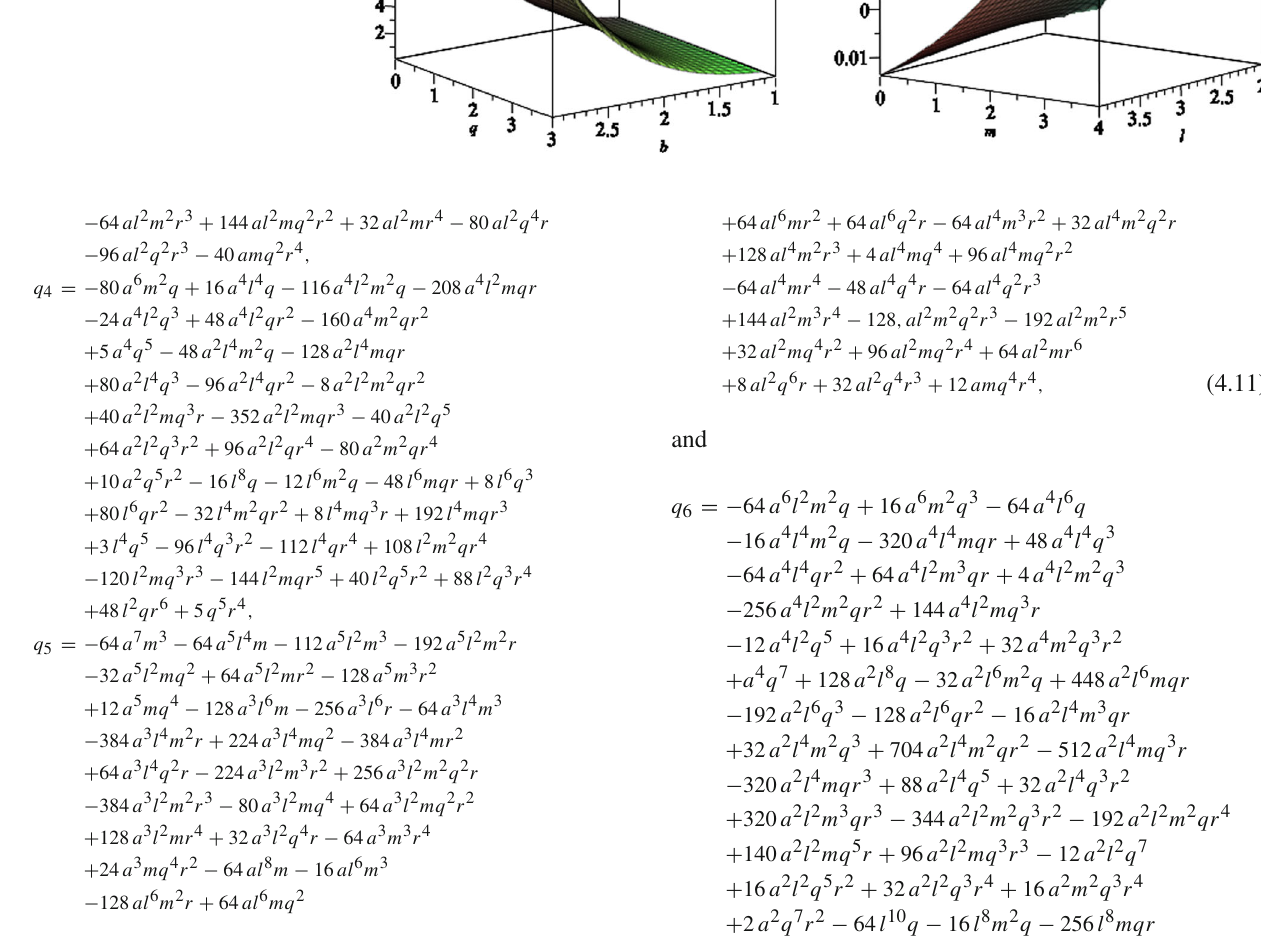
Fig. 13 The angular velocity of the horizon as function of q , b (left) and m , l (right), where we set the other black hole parameters to a set of fixed